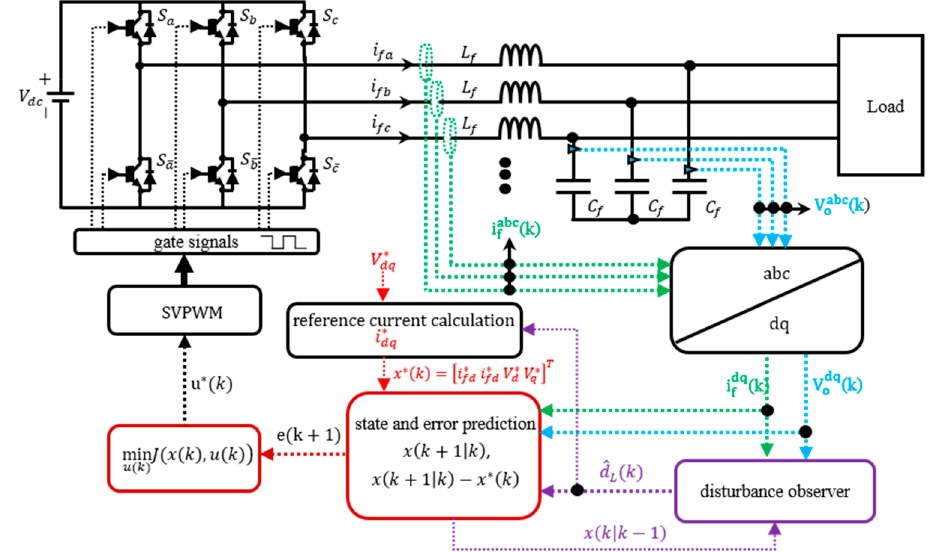
Figure 4. General block diagram of the system.